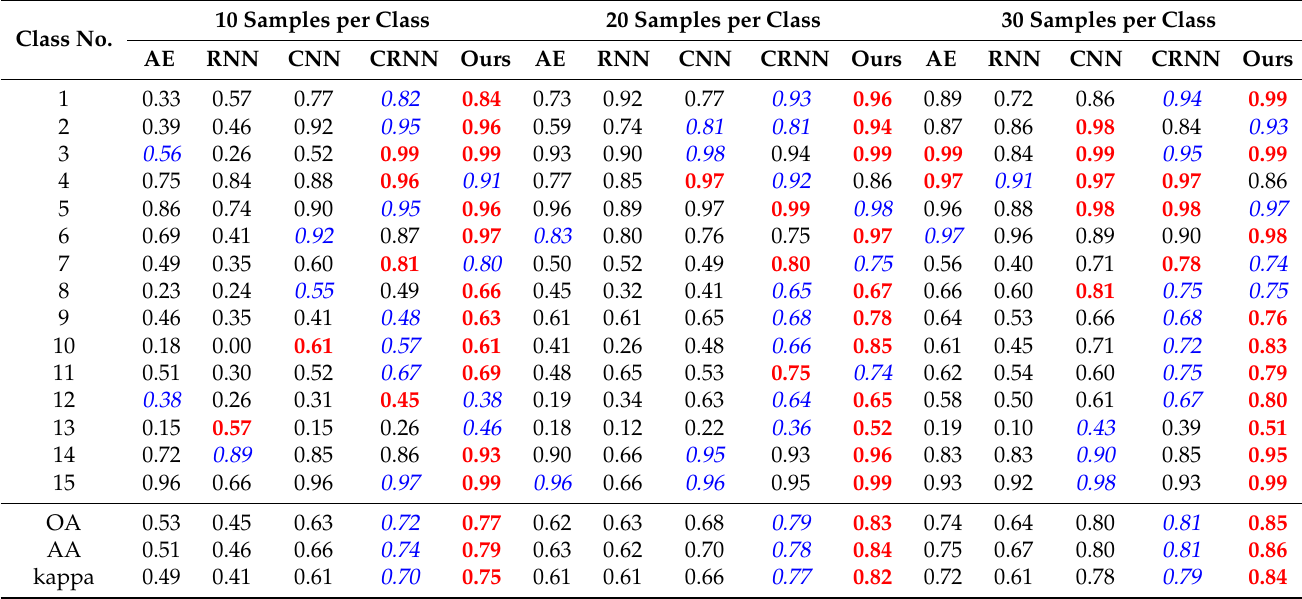
Table 6. Classification Results for a Small Number of Training Samples on Houston 2013. The red bold fonts and blue italic fonts indicate the best and the second best performance.